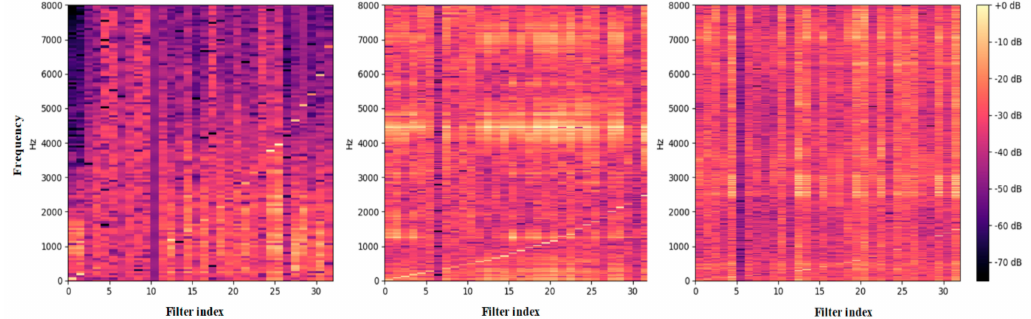
Figure 8. Frequency magnitude response of the multi-scale convolutional filters of the first layer. The filters are sorted by their center frequency. Left shows the frequency response of the low-scale network, middle shows the frequency response of the mid-scale network, and right shows the frequency response of the high-scale